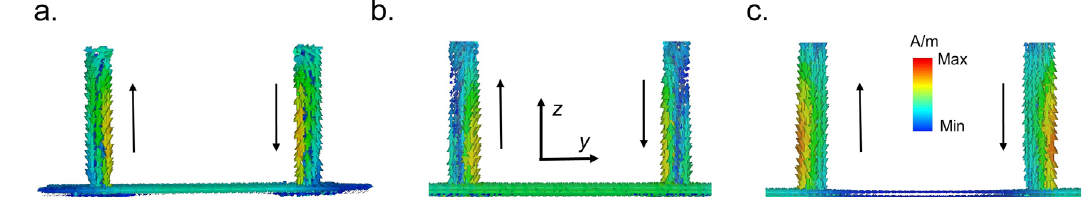
Fig. 4. Surface current distributions on the metallic via holes under the illumination of a y -polarized EM wave at the frequency of (a) 10GHz, (b) 14GHz, and (c)